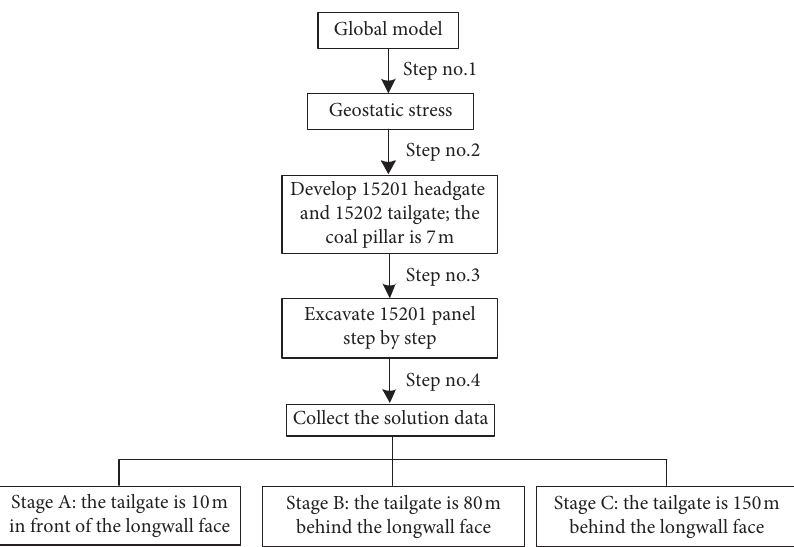
Figure 8: Numerical simulation